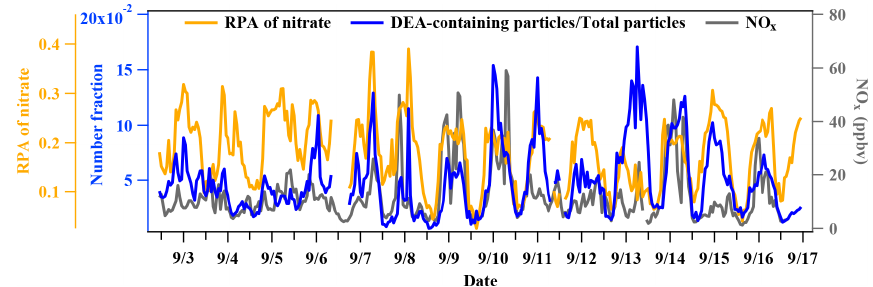
Figure 9. Temporal trends of RPA nitrate in DEA-containing particles, number fraction of DEA-containing particles in total particles, and NO x